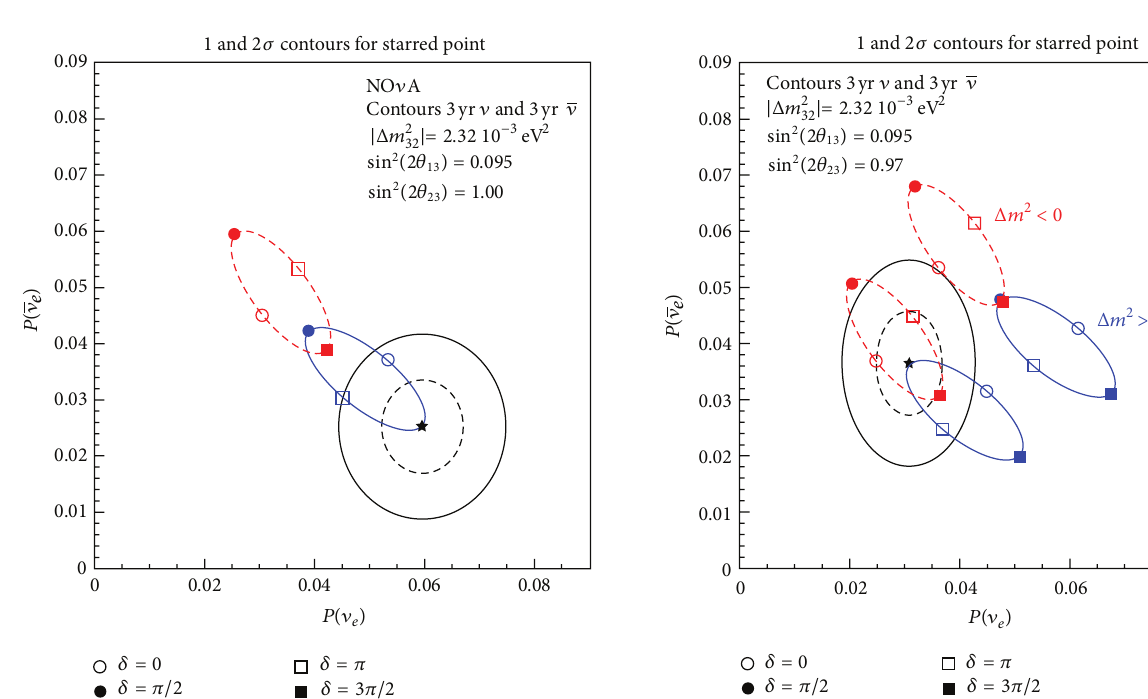
Figure 27: Biprobability plot for sin 2 (2𝜃 23 ) = 1.00 with NO 𝜈 A expected 1 and 2 standard deviation contours superimposed on the starred point.